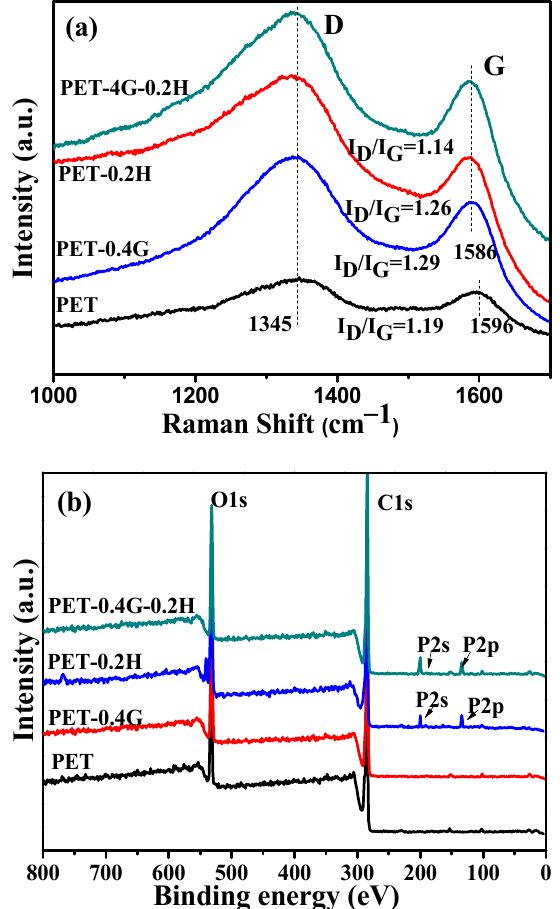
Figure 9. Raman spectra ( a ) and XPS ( b ) scan spectra of char residue of neat PET and its compo- sites.